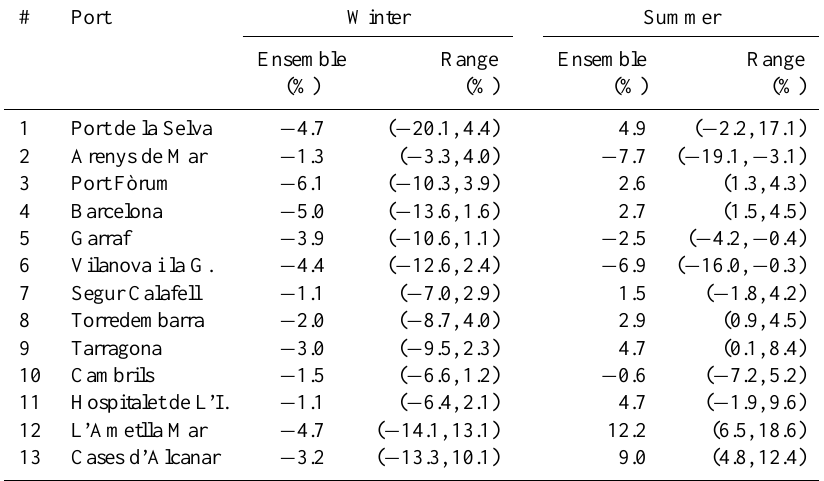
Table 4. Projected change (future minus present in %) in the spatial averaged H s inside the port for the winter and summer seasons, respectively, in terms of the ensemble and the range of variation among the five models.